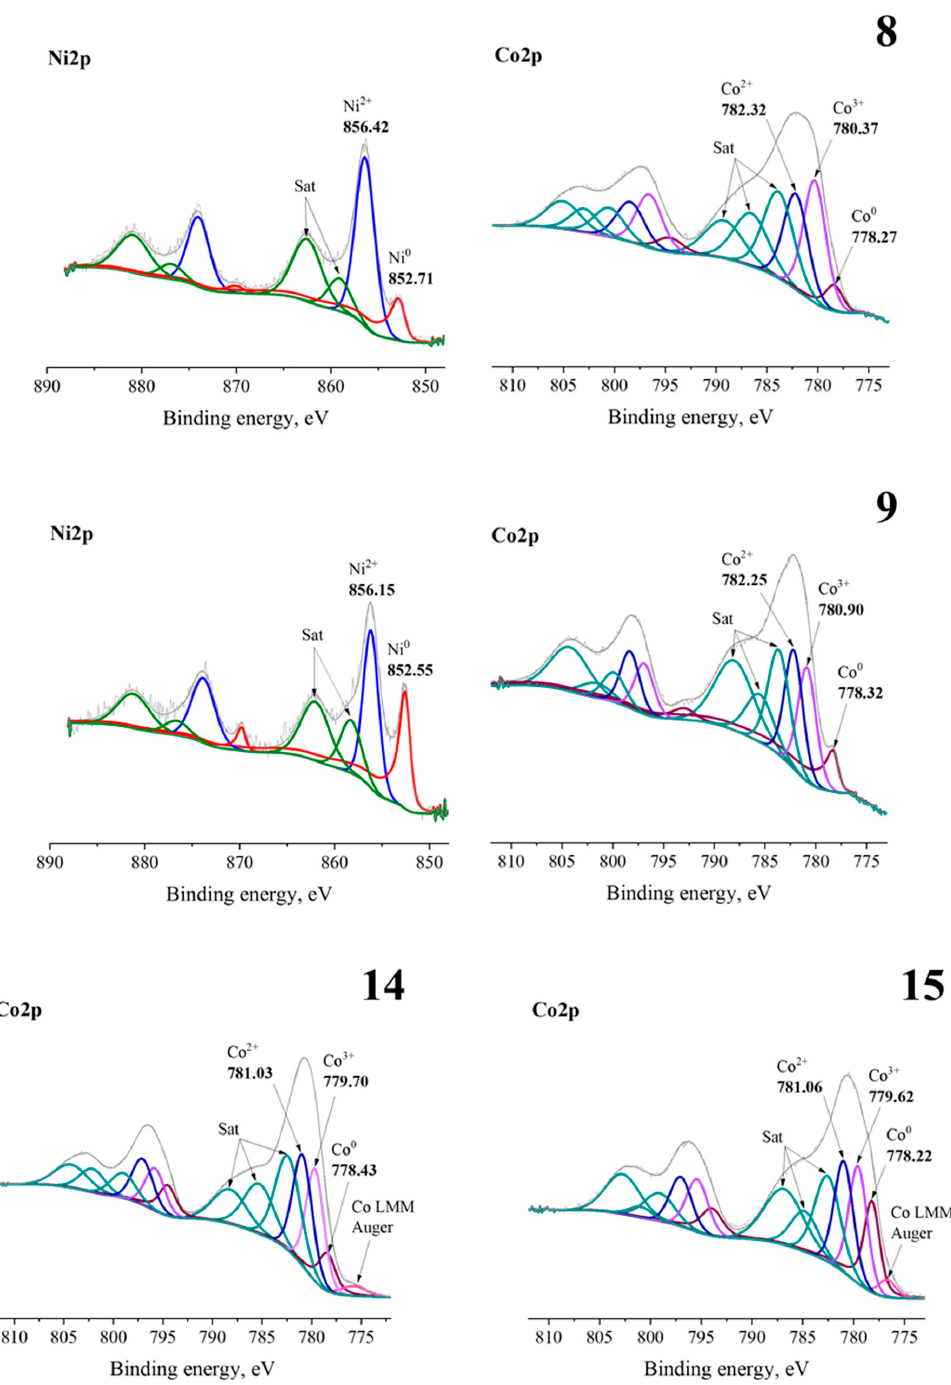
Figure 2. Ni2p XPS spectra: ( 2 )—20%Ni/WC_IWI and ( 3 )—20%Ni/WC_DP; Ni2p and Co2p XPS spectra: ( 8 )—10%Ni_10%Co/WC_IWI and ( 9 )—10%Ni_10%Co/WC_DP; Co2p XPS spectra: ( 14 )—20%Co/WC_IWI and ( 15 )—20%Co/WC_DP.